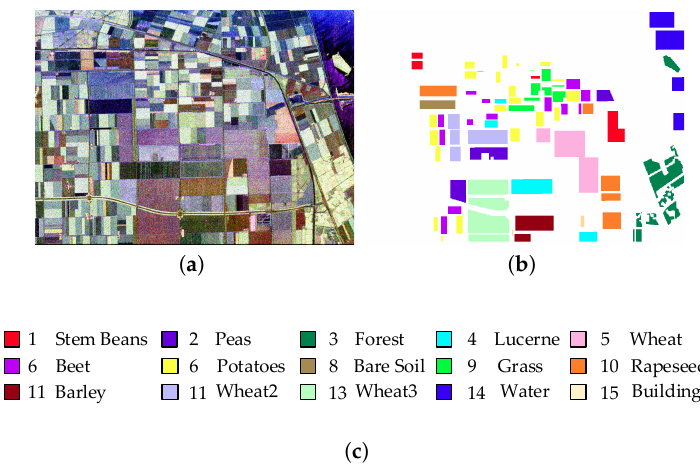
Figure 4. ( a ) The Pauli color-code image of Flevoland data set. ( b ) The corresponding ground truth. ( c ) The legend of the ground truth.